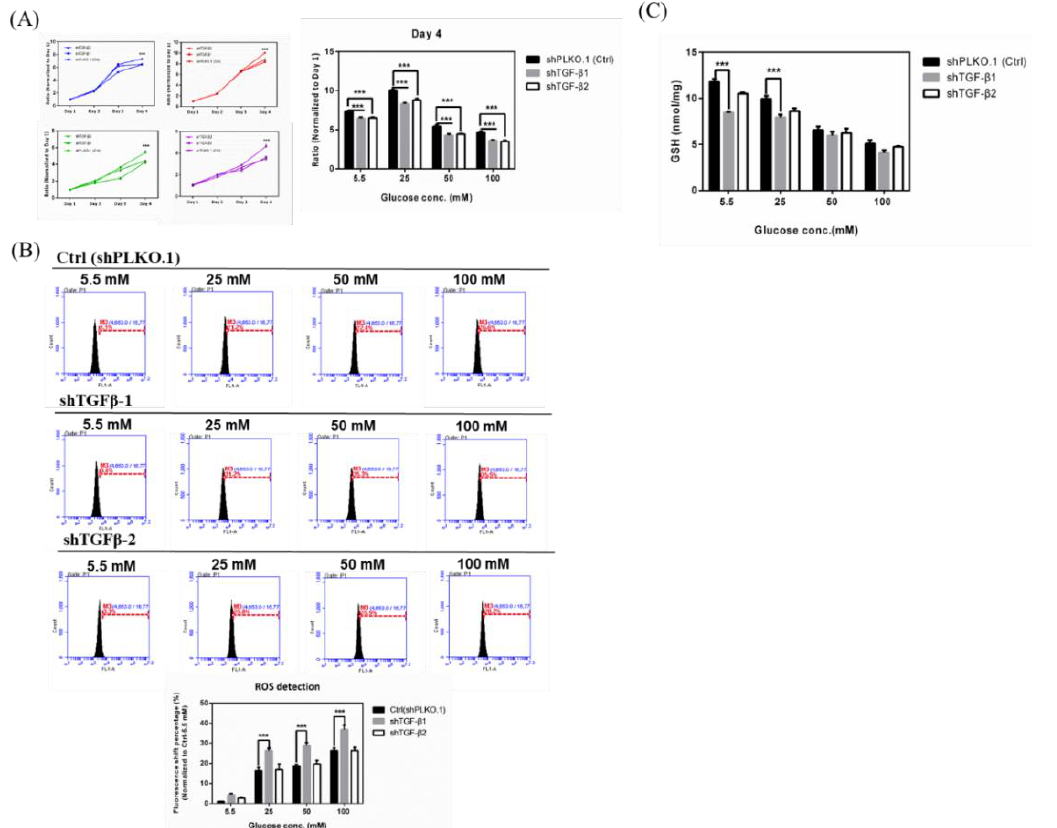
Figure 4. E ff ects in TGF- β 1 / 2 knockdown RGCs with hyperglycemia. ( A ) Left: Cell proliferation rates under di ff erent glucose concentrations were observed from Day 1 to Day 4 by cell viability assay. The data from Day 2, Day 3, and Day 4 were normalized to Day 1. TGF- β 1 / 2 knockdown RGC-5 cells were incubated in 5.5 mM, 25 mM, 50 mM, and 100 mM glucose for 3 weeks or longer and plated into 96-well plates to observe the proliferation rate in di ff erent glucose concentrations. Right: Isolated Day 4 data show the di ff erential proliferation rate in TGF- β 1 / 2 knockdown in RGC-5 cells in four di ff erent glucose concentrations. Data are represented as mean ± SEM. ***, p < 0.001 when compared to shPLKO.1 (Ctrl). ( B ) Upper: iROS production in TGF- β 1 / 2 knockdown RGCs with hyperglycemia. Intracellular ROS accumulations were assessed by the APF detection method in TGF- β 1 / 2 knockdown RGC-5 cell cultures in long-term di ff erent glucose concentrations (5.5 mM, 25 mM, 50 mM, and 100 mM glucose). After exposure, 106 cells were treated with APF (5 µ M) in PBS (phosphate bu ff ered saline). Intracellular ROS generation was quantified by flow cytometry. ( n = 3) Lower: Relative fluorescence shift percentage was quantified and normalized with respect to the shPLKO.1 (5.5 mM) group. Data are represented as mean ± SEM. ***, p < 0.001 when compared to shPLKO.1 (Ctrl). ( C ) GSH content in TGF- β 1 / 2 knockdown RGCs with hyperglycemia. Dose responses involving total GSH levels in TGF- β 1 / 2 knockdown cells treated with 5.5 mM, 25 mM, 50 mM, and 100 mM glucose medium were assayed. Data are represented as means ± SEM. ***, p < 0.001 when compared to the shPLKO.1